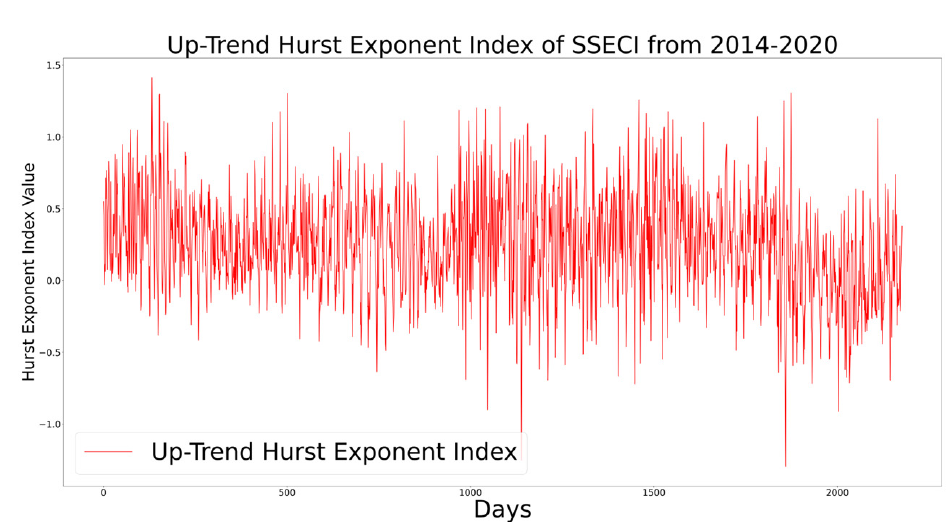
Figure 5. The graph of up-trend Hurst exponent index of